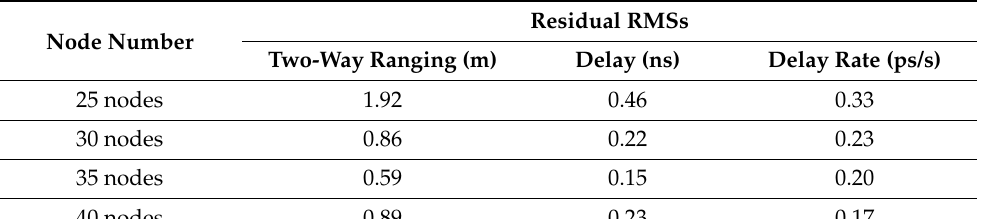
Table 4. Residual RMSs of ranging, delay and delay rate by selecting different nodes in the method based on B-spline function during ascent.